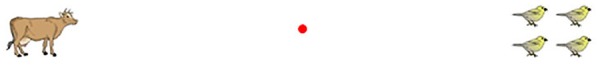
Example visual display from a different-number trial.